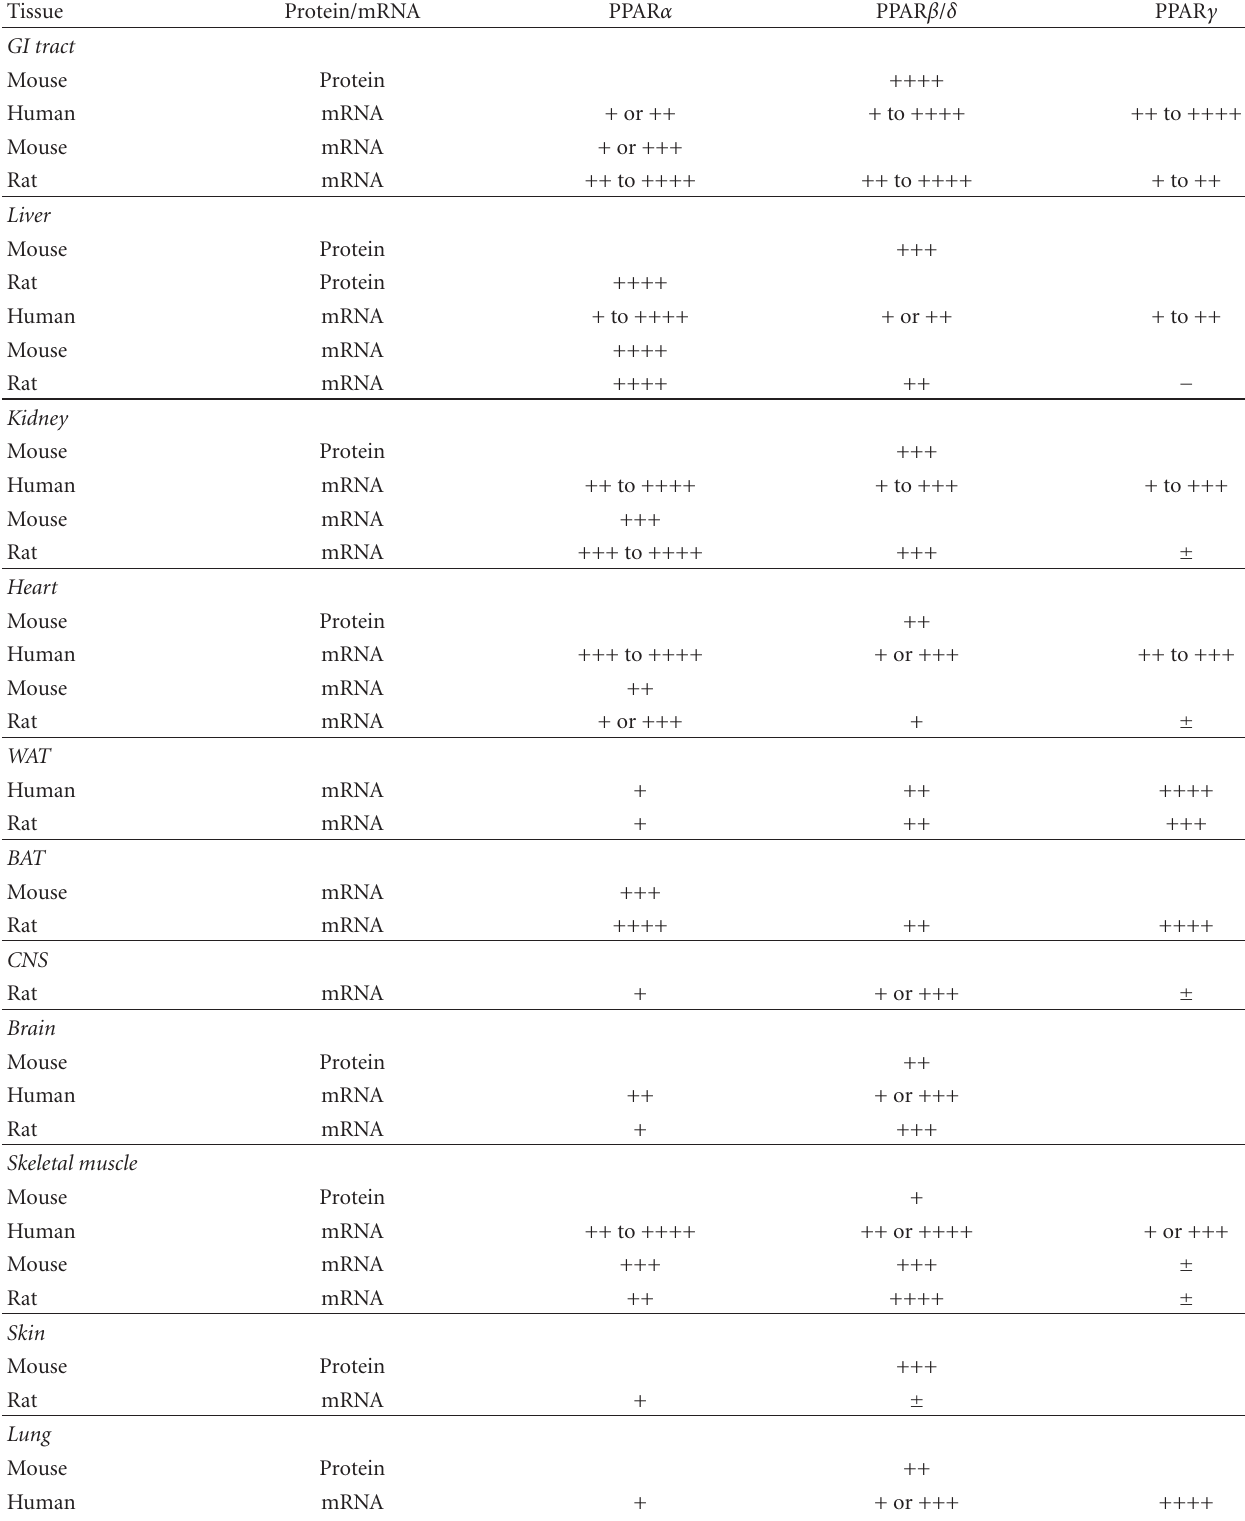
Table 1: Tissue distributions of the various PPARs (RNA and protein) in adult rodents and humans. Abbreviations: GI, gastrointestinal; WAT, white adipose tissue; BAT, brown adipose tissue; CNS, central nervous system. Symbols: − , absent; ± , barely detectable; +, weak; ++, moderate; +++, high; ++++, very high (Taken from [26, 28, 45]). Tissue Protein/mRNA PPAR α PPAR β / δ PPAR